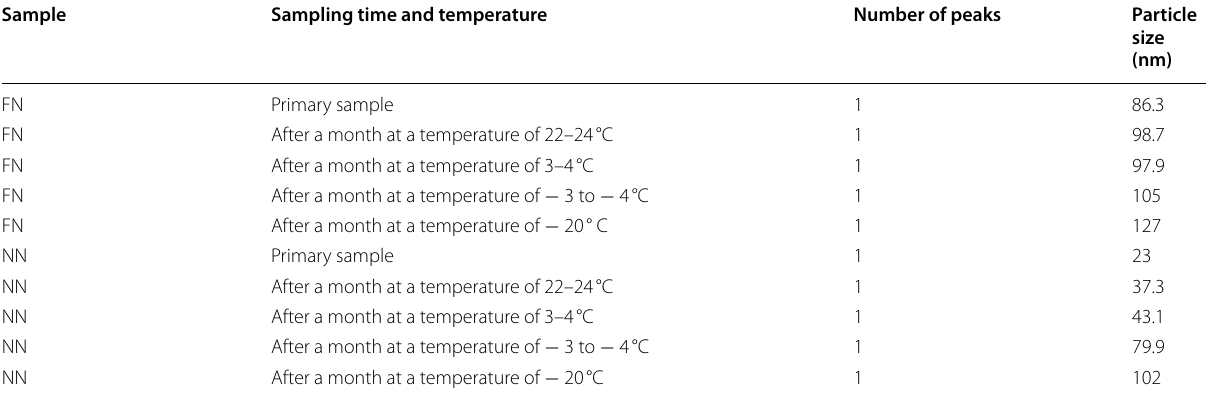
Table 2 DLS results of the optimum sample and the 30-day stability at different temperatures Sample Sampling time and temperature Number of peaks Particle